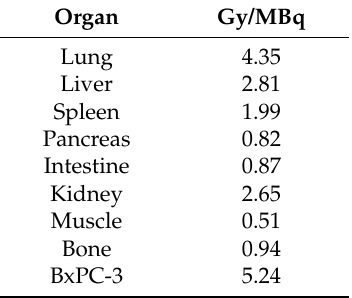
Table 2. Absorbed dose of 90 Y-labeled anti-CD147 antibody 059-053 to major organs and BxPC-3